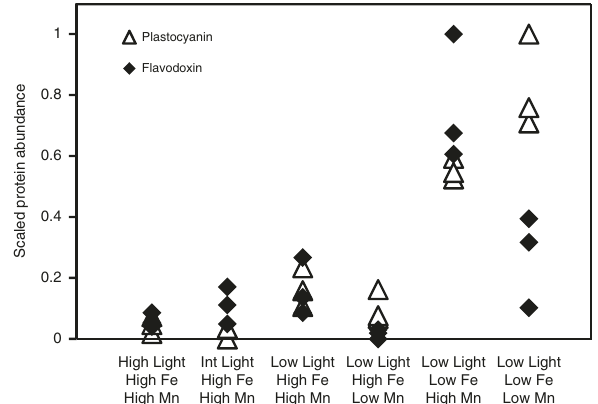
Fig. 4 Plastocyanin and fl avodoxin abundance. In Phaeocystis cultures, plastocyanin levels are elevated under − Fe regardless of Mn availability, while fl avodoxin levels are elevated under − Fe only when cultures are Mn replete, possibly re fl ecting fl avodoxin ’ s role in reactive oxygen species (ROS) management. The expression of both proteins does not change signi fi cantly as a function of irradiance level. Protein expression values scaled from 0 to 1. Source data are provided in the Source Data